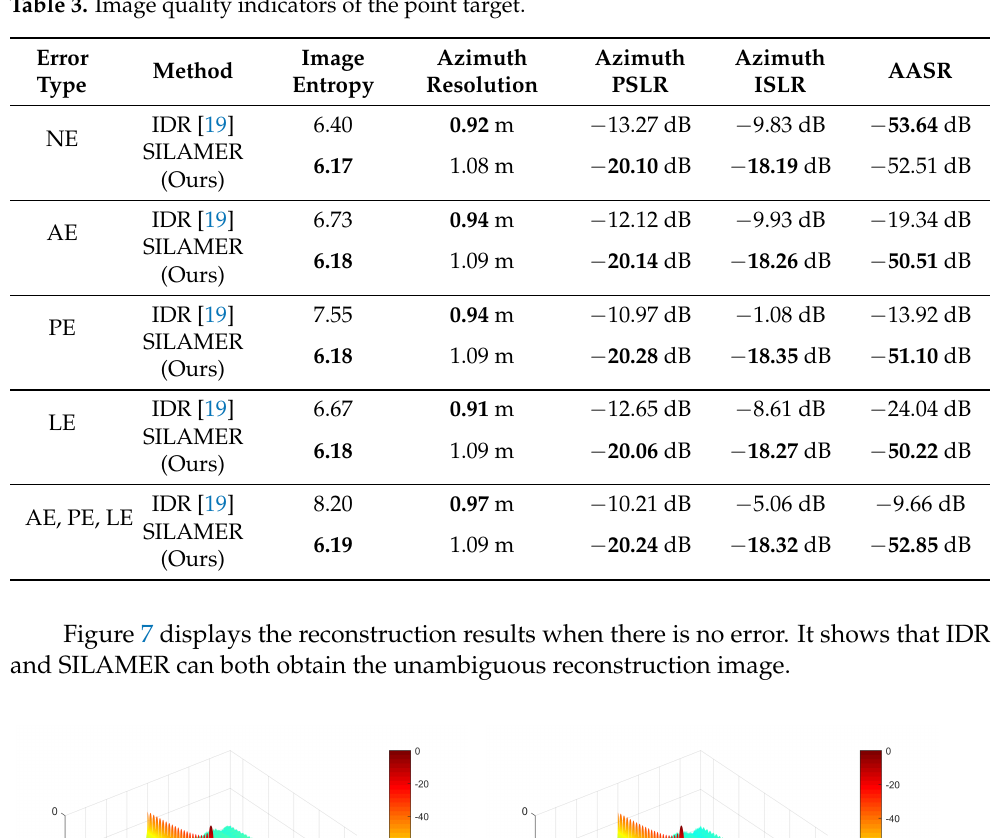
Table 3. Image quality indicators of the point target.